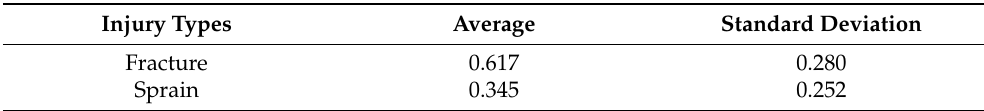
Table 3. Averaged multilayer perceptron outputs (over 100 trials) for participants in the test file, investigation B. The values have no units.